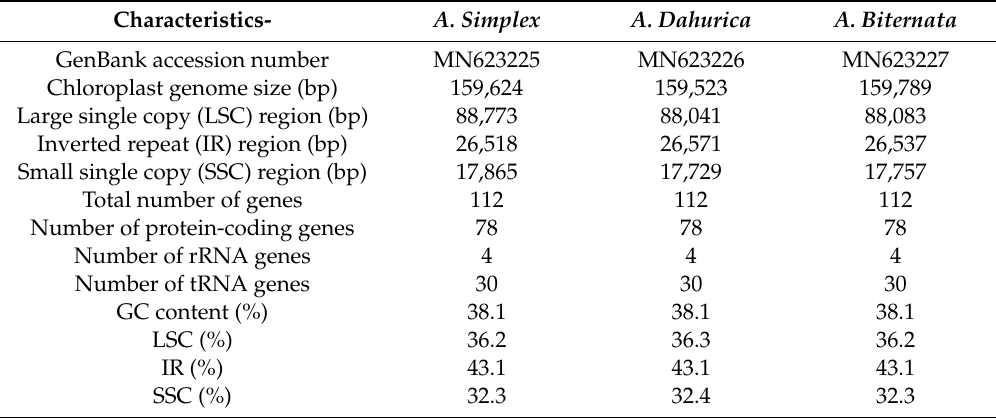
Table 1. Characterization of the cp genomes of three Actaea